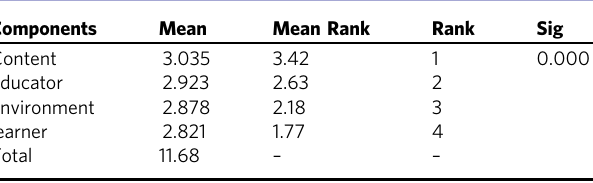
Research fi ndings.